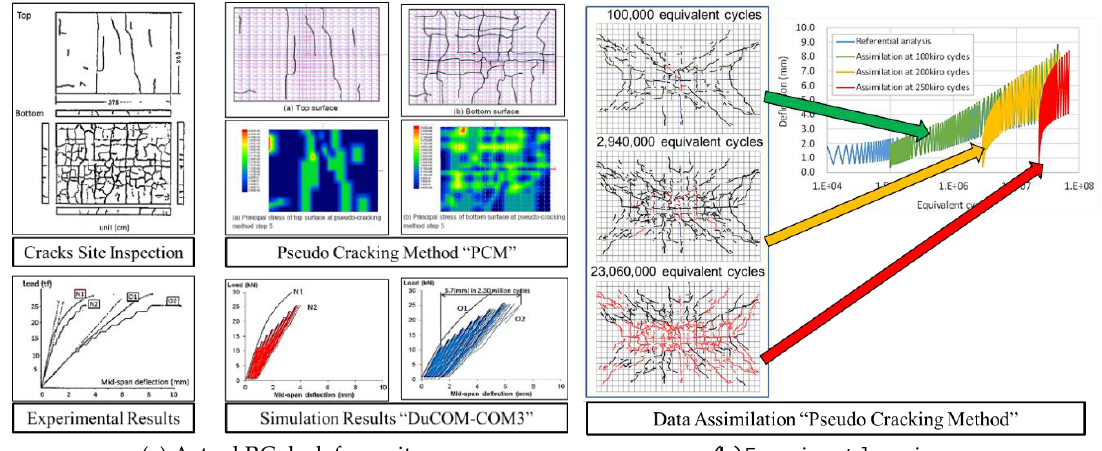
Figure 3. Validations of data assimilation technology.